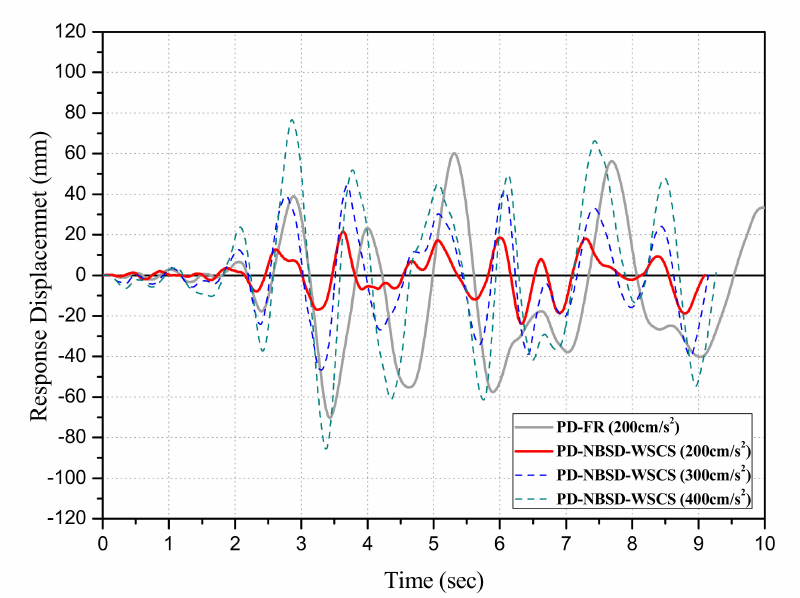
Figure 21. Comparison of seismic response shear stress–displacement